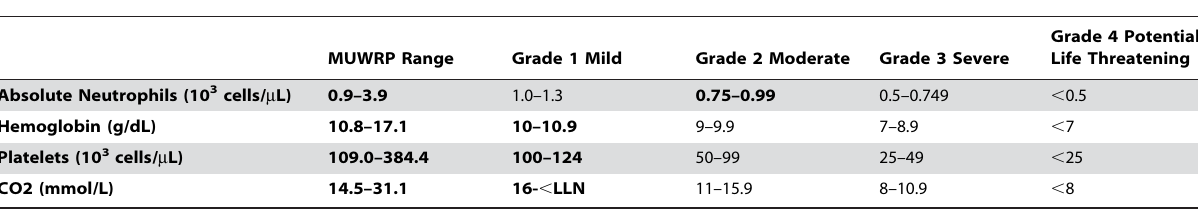
Table 4. DAIDS Toxicity Table Overlap, the Grade refers to the Adverse